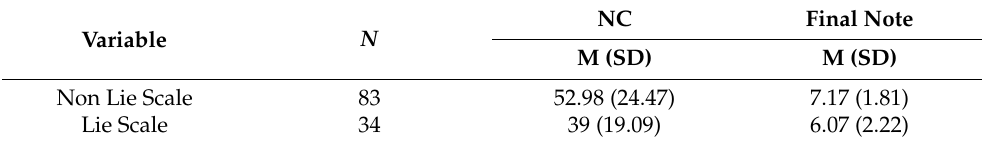
Table 5. Correlation of lie scale group and non lie scale group with narrative creativity and final note. NC Final Note Variable N M (SD) M (SD) Non Lie Scale 83 52.98 (24.47) 7.17 (1.81) Lie Scale 34 39 (19.09) 6.07